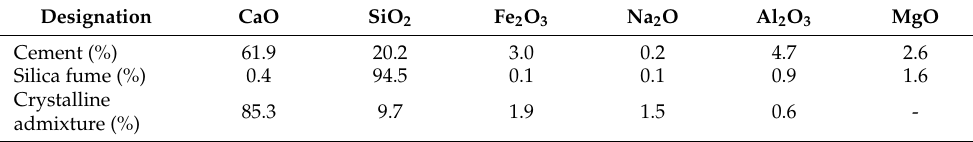
Table 3. Composition of crystalline admixture compared with cement and silica